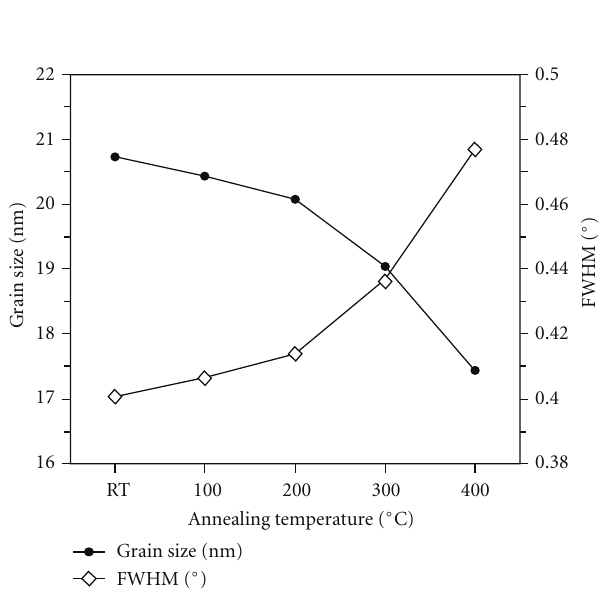
Figure 5: The grain sizes and FWHMs of the AZO films before and after annealing at di ff erent temperatures.